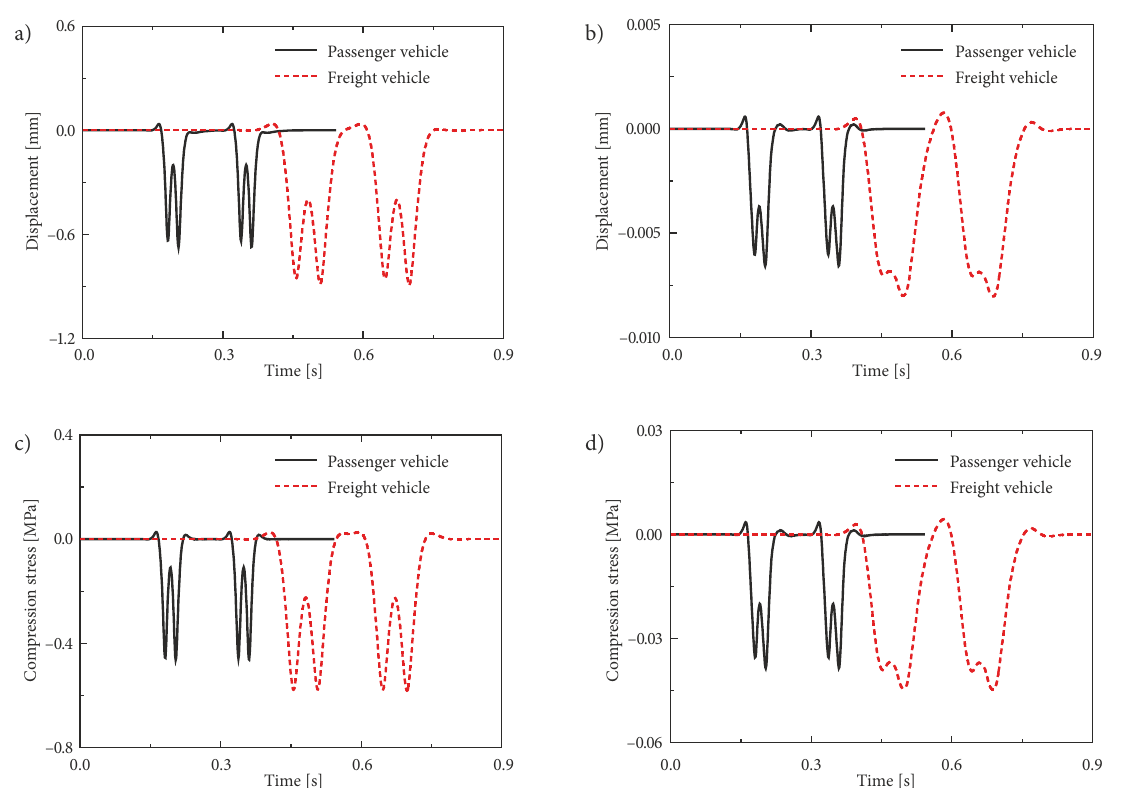
Figure 5. Dynamic characteristics of track structures: a – rail displacement; b – supporting layer displacement; c – compression stress of concrete slab; d – compression stress of supporting layer